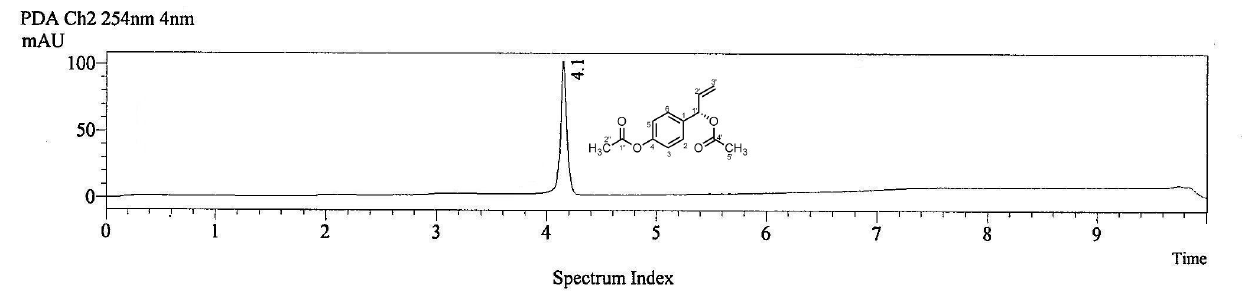
Figure 2. Chromatogram of 1’ S -1’-acetoxychavicol acetate at 254